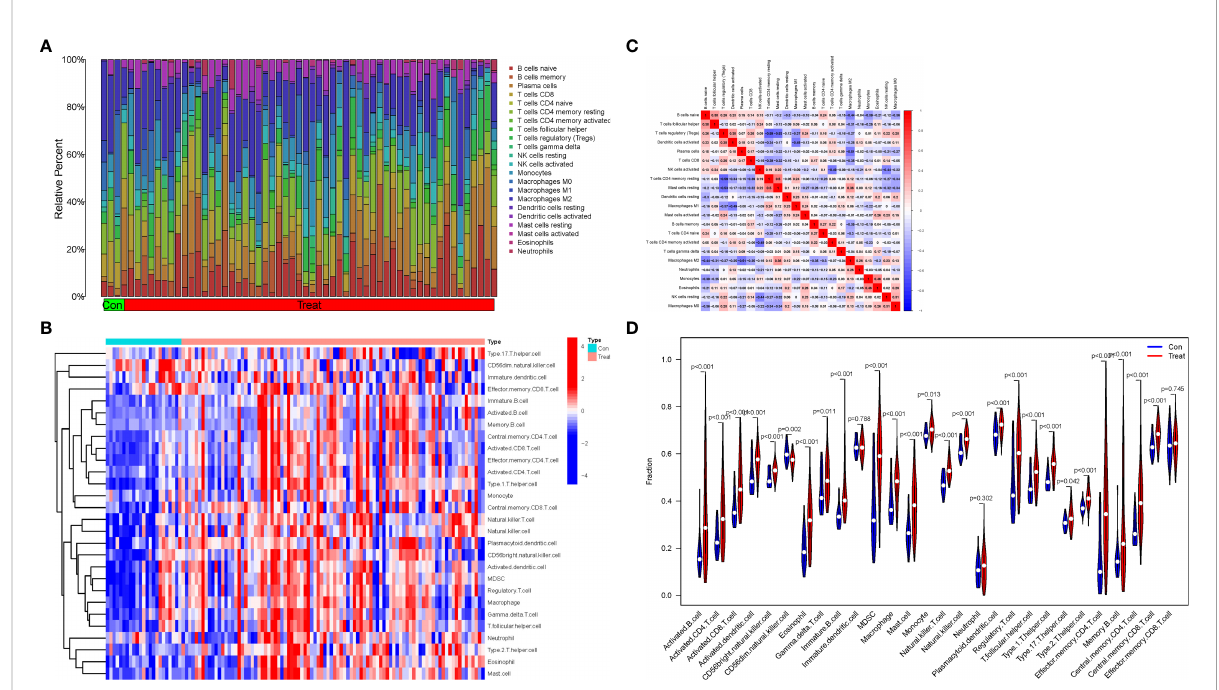
FIGURE 6 Immune in fi ltration analysis and the correlations between the in fi ltrating immune cell types. (A) The proportion of 22 in fi ltrating immune cell types in Treat and Con groups. (B) The distribution of the 28 in fi ltrating immune cell types in Treat and Con groups. (C) The correlations heatmap between the in fi ltrating immune cell types. (D) Violin plot demonstrating the differences between the 28 immune cell types in the Treat and Con